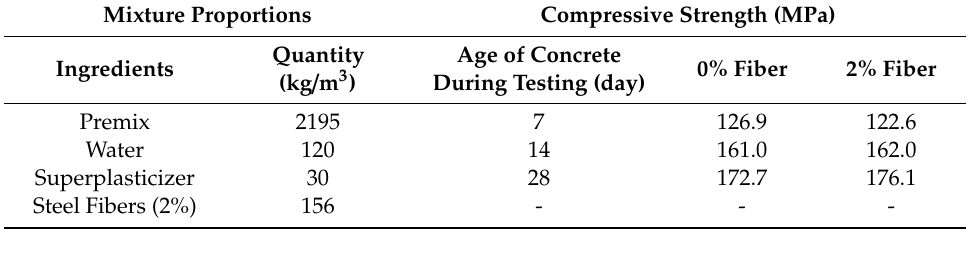
Table 2. Mixture proportions and compressive strength of UHPC (Adapted from [7,25]).